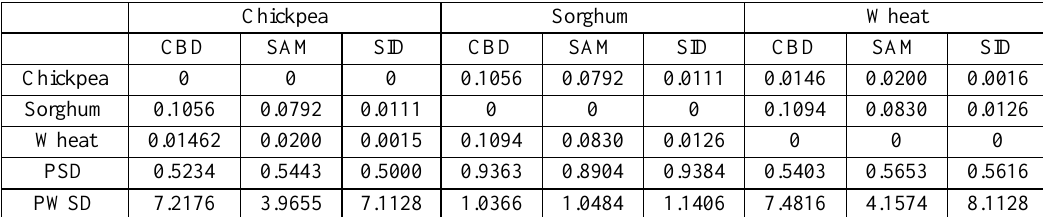
Table 8: Spectral similarity and discriminatory values: Spectra developed precisely based on spectral similarity